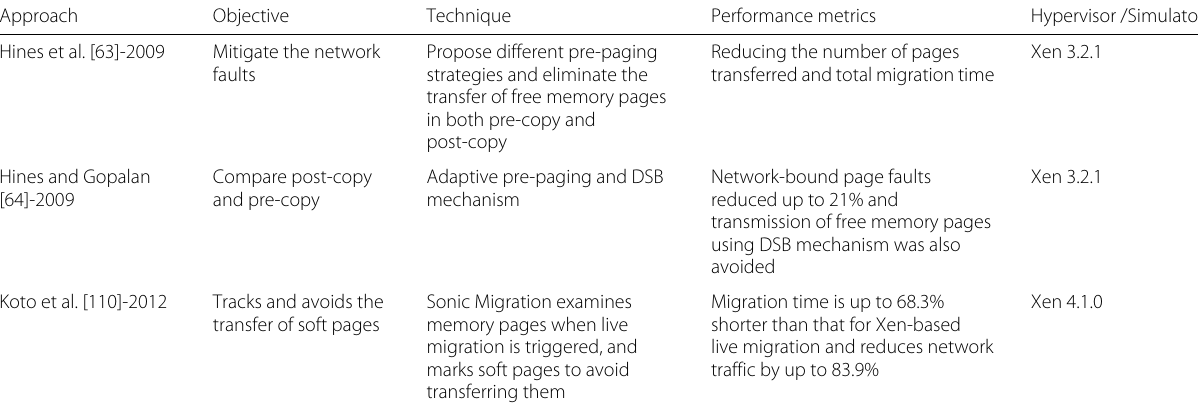
Table 11 Comparison of Soft page aware VM migration approaches